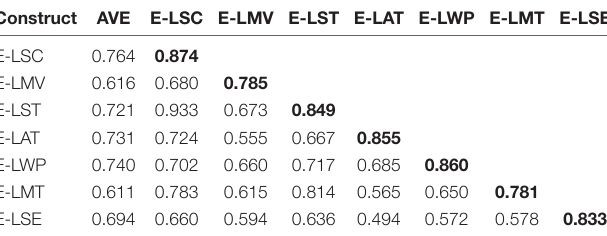
The shaded numbers in the diagonal row are square roots of the AVE. Off-diagonal elements are the correlations among